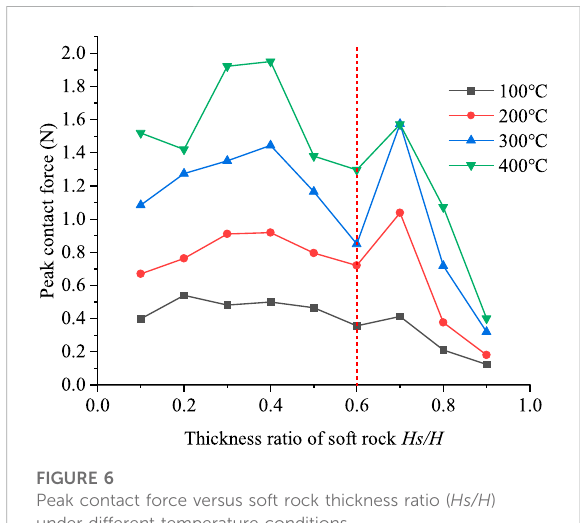
FIGURE 5 The relationship curve between peak displacement and loading temperature under different thickness ratios of soft rock ( Hs/H ).